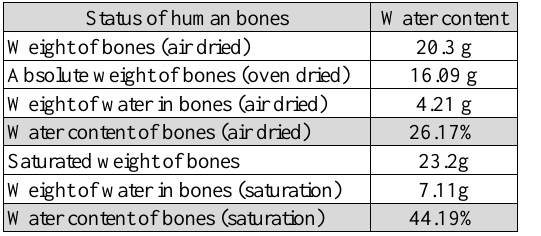
Table 1. Physical characteristics of experimental bone sample.